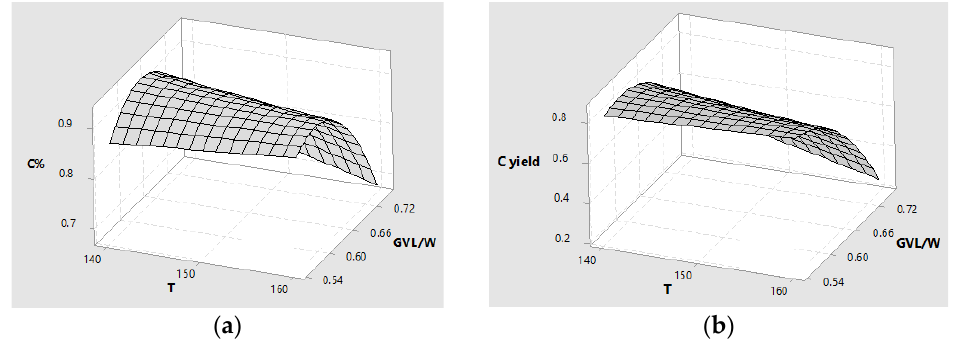
Figure 1. Response surface of the DoE. The factors are temperature and GVL/water solution con- centration; in ( a ), the response is cellulose content (C%); in ( b ), the response is cellulose recovery yield (CY).